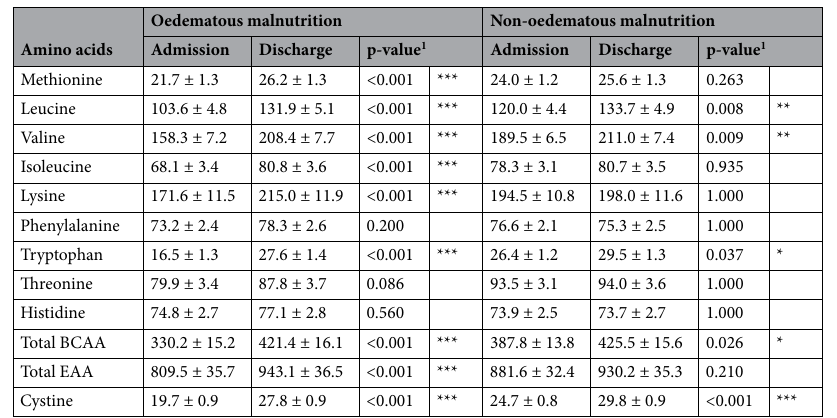
Table 4. Predicted plasma amino acid concentrations and comparison between admission and discharge for each SAM subgroup. Predicted concentrations are expressed as the means ± SEs (μM). 1 P-values were obtained from the general linear hypotheses test (null hypothesis: the difference between admission and discharge = 0), and p < 0.05 indicated a significant difference between admission and discharge. All specimens described as “Analysis” in Fig. 2 were used for this